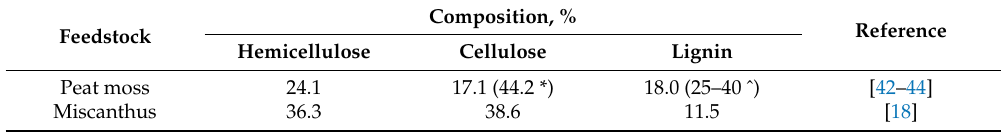
Table 1. Major components in the feedstocks.